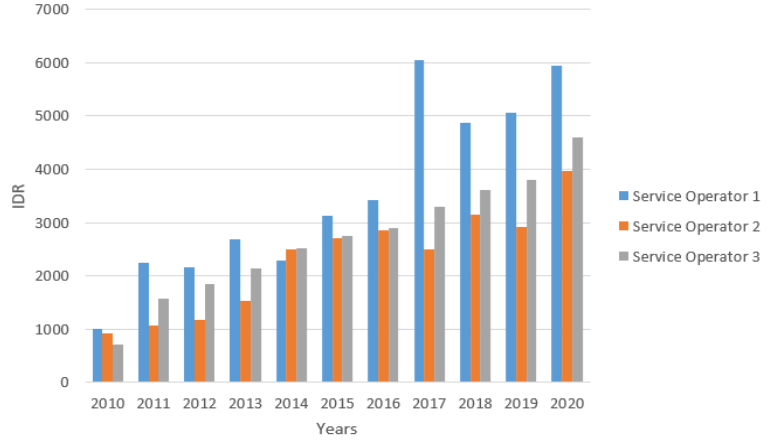
Figure 5. Spectrum usage fees of the three biggest service operators in Indonesia (IDR Million) [41–44]